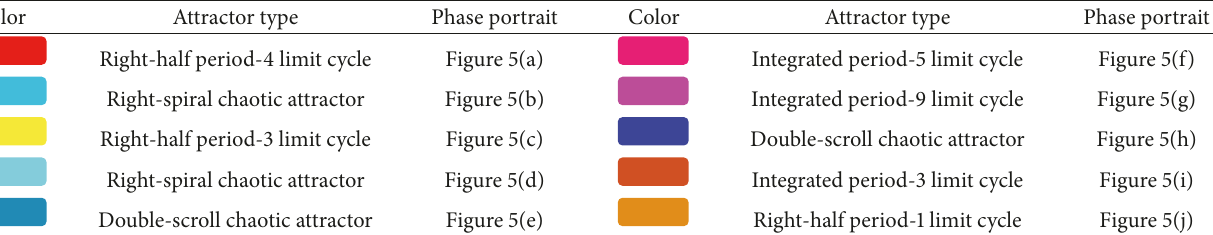
Table 3: Attractor types in different attraction regions of Figure